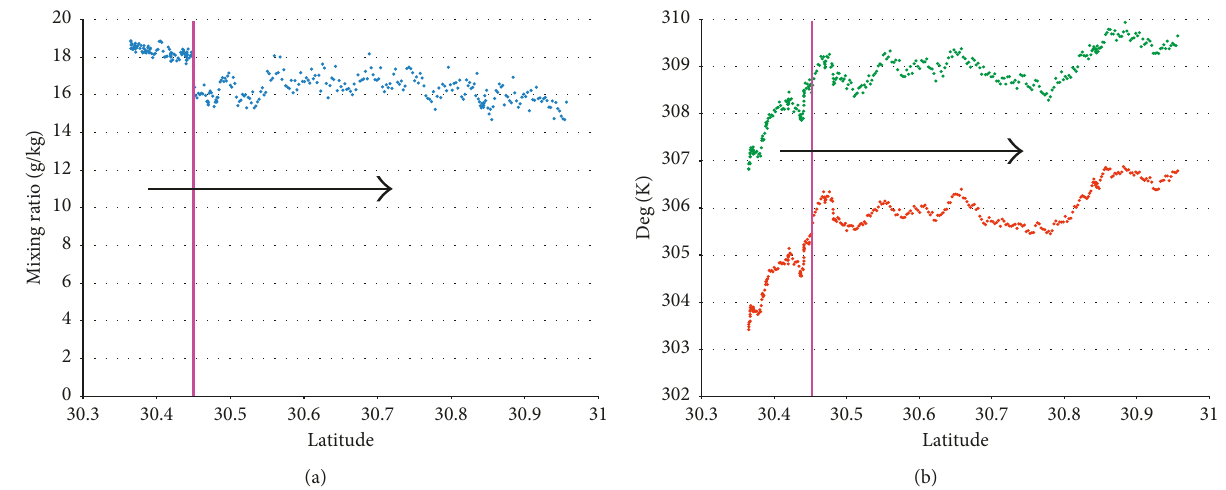
Figure 9: Space series versus latitude on 6 August 2014. (a) Mixing ratio (g/kg) and (b) potential temperature (red) and virtual potential temperature (green)